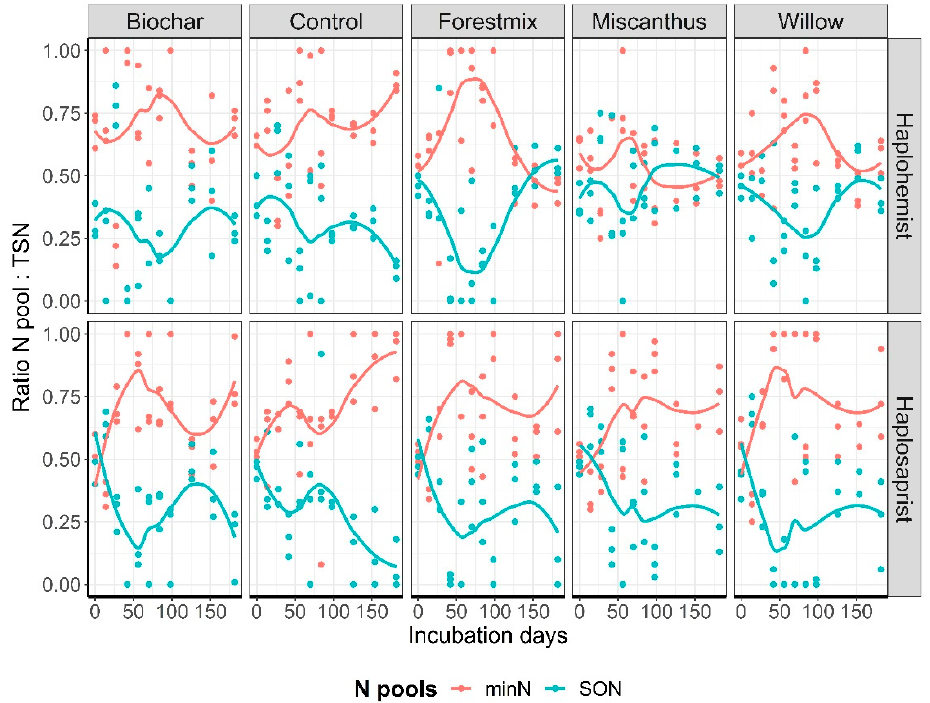
Figure 7. Temporal evolution of the MinN:TSN and SON:TSN ratios as a function of soil type and amendment. Note that SON is calculated as the difference between TSN and MinN, which explains the inverse relationship observed between the two N pools.